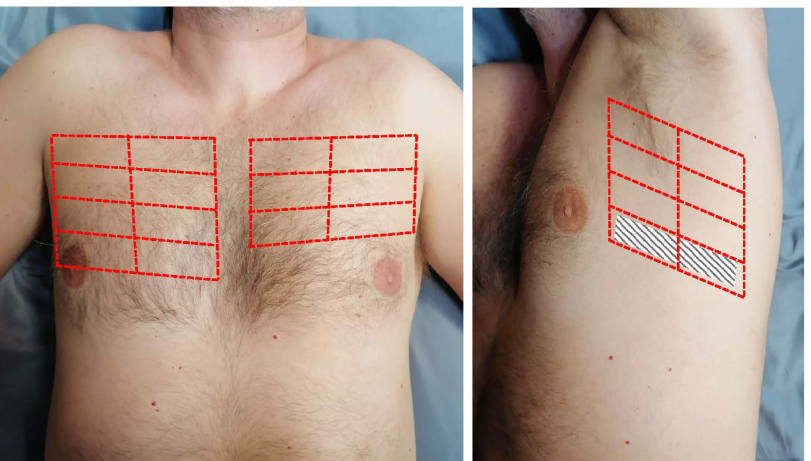
Figure 1. The 28-zone lung ultrasound scanning scheme. The chest is divided along the parasternal, midclavicular, anterior axillary and mid-axillary lines, from the second to the fifth intercostal space on the right hemithorax and from the second to the fourth intercostal space on the left hemithorax, for a total of 16 scanning zones on the right and 12 scanning zones on the